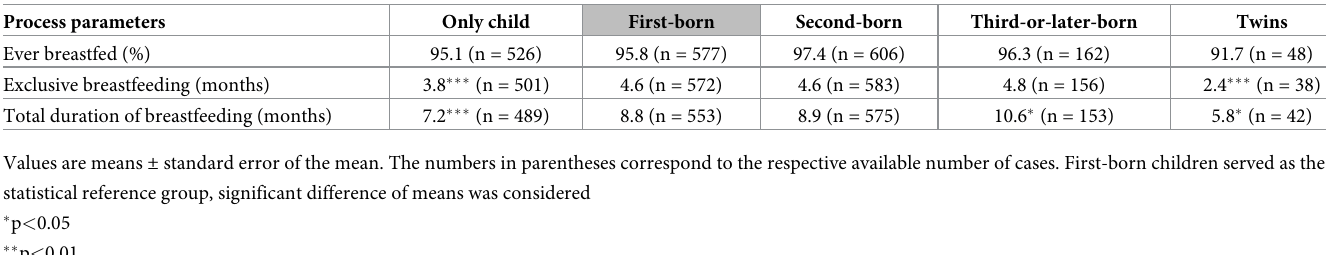
our findings by comparing siblings and showing that maternal gestational weight gain was associated with a higher birth weight, but not with the child’s BMI [35]. Most likely, factors other than prenatal factors and birth weight could have contributed to the BMI differences between siblings and only children. Postnatal risk factors seem to have a stronger association with BMI-SDS difference between first-borns and only children in adoles- cence. We therefore investigated two known postnatal factors individually by birth order to clarify their influence on BMI: breastfeeding and physical activity. The duration of breastfeed- ing was significantly lower for only children compared to single-born siblings. Exclusive